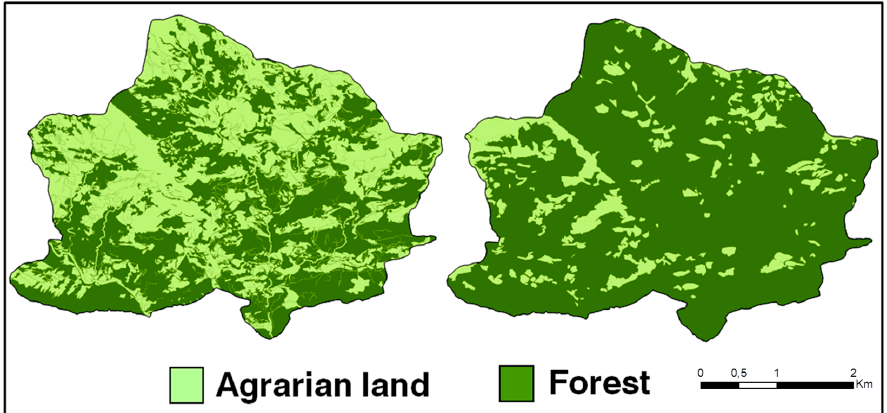
Figure 4. Forest vs. non-forest habitats.